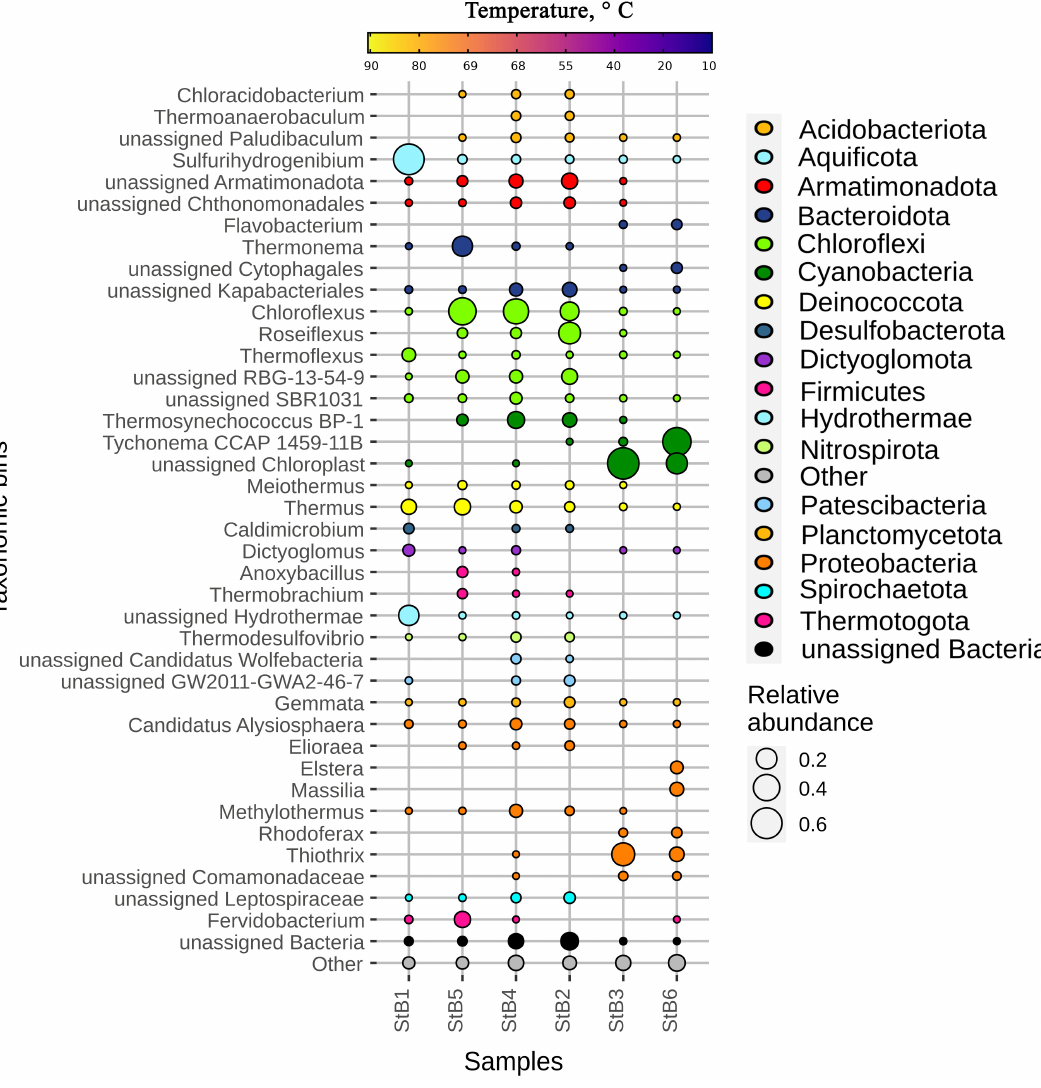
Figure 4. The most abundant bacterial genera/phyla in the microbial biofilms developing at different temperatures. Circle size indicates the inferred relative abundance based on amplicon numbers (in %).